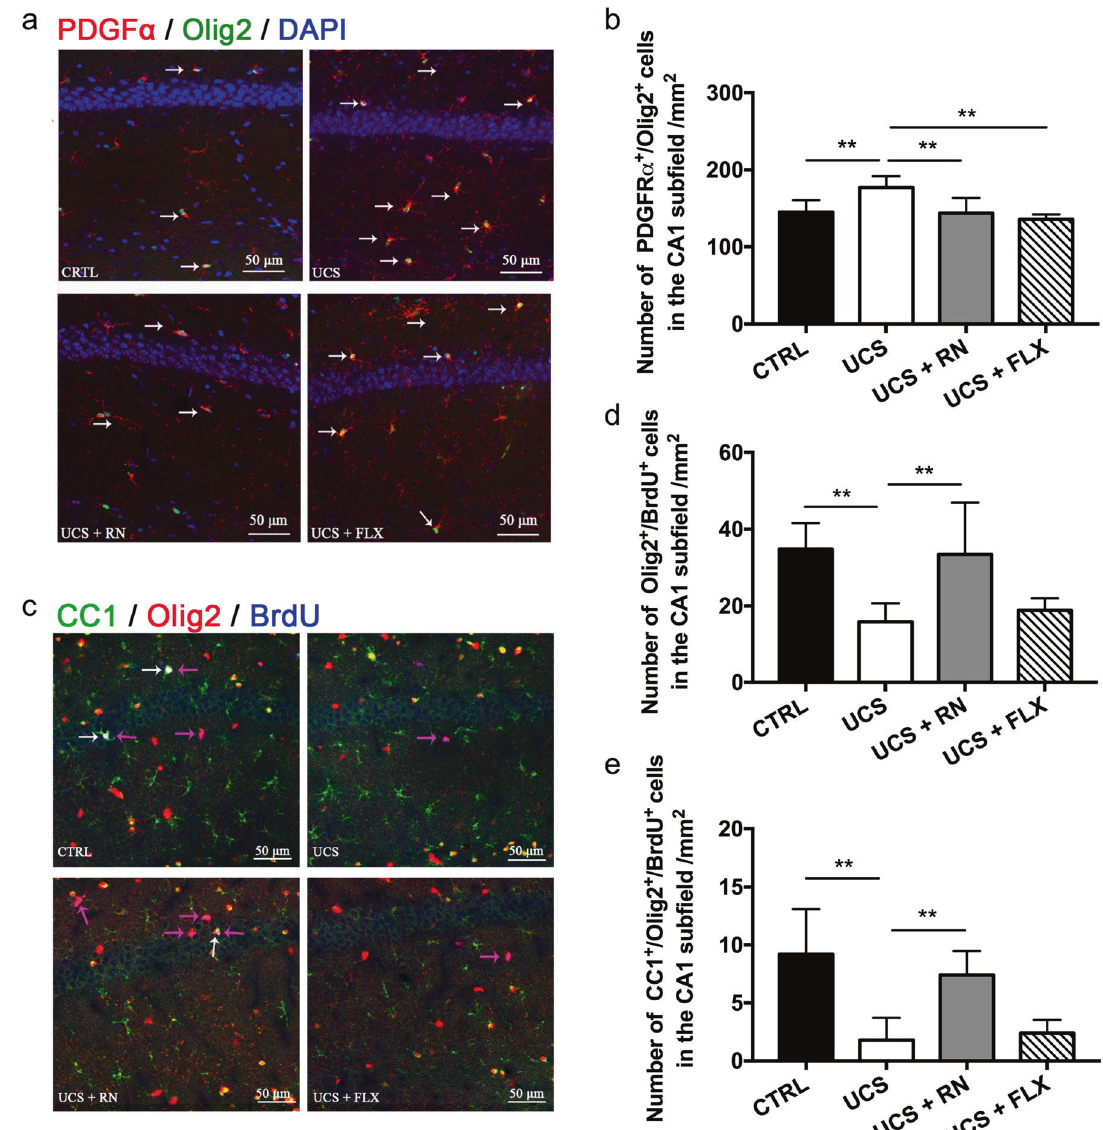
Fig. 4 The effects of running exercise and fl uoxetine on the OPC proliferation and differentiation in the CA1 sub fi eld of the hippocampus. a Colocalization of PDGF α + and Olig2 + cells in the CA1 sub fi eld of the hippocampus. PDGF α + : red, Olig2 + : green, DAPI: blue. The white arrows indicate PDGF α + /Olig2 + /DAPI co-labeled cells. Scale bar = 50 μ m. b Immuno fl uorescence analyses of the PDGF α + /Olig2 + cells in the CA1 sub fi eld of mice in the CTRL group, UCS group, UCS + RN group, and UCS + FLX group ( n = 5 for each group). c Colocalization of CC1 + , Olig2 + , and BrdU + cells in the CA1 sub fi eld of the hippocampus. CC1 + : red, Olig2 + : green, BrdU + : blue. The white arrows indicate the CC1 + /Olig2 + /BrdU + co-labeled cells, and the pink arrows indicate the Olig2 + /BrdU + co-labeled cells. Scale bar = 50 μ m. d , e Immuno fl uorescence analyses of the BrdU + /Olig2 + and CC1 + /BrdU + /Olig2 + cells in the CA1 sub fi eld of mice in the CTRL group, UCS group, UCS + RN group, and UCS + FLX group ( n = 5 for each group). All data are shown as the means ± SDs. ** P <